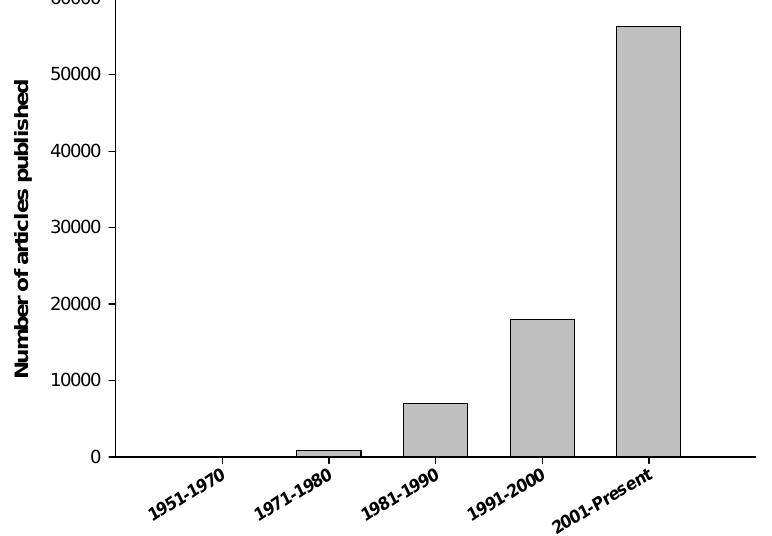
Figure 1. The number of articles published on glucose monitoring during the mentioned period. Data was taken on July 1, 2013, from Thomson Reuter’s Web of Knowledge (New York, NY, USA) using “glucose monitoring” in the